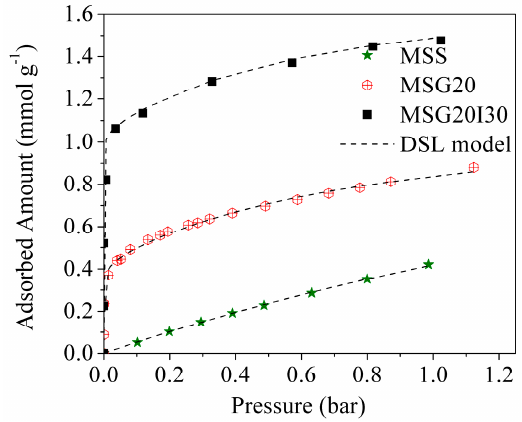
Figure 7. CO 2 isotherms at 25 °C for mesoporous materials.